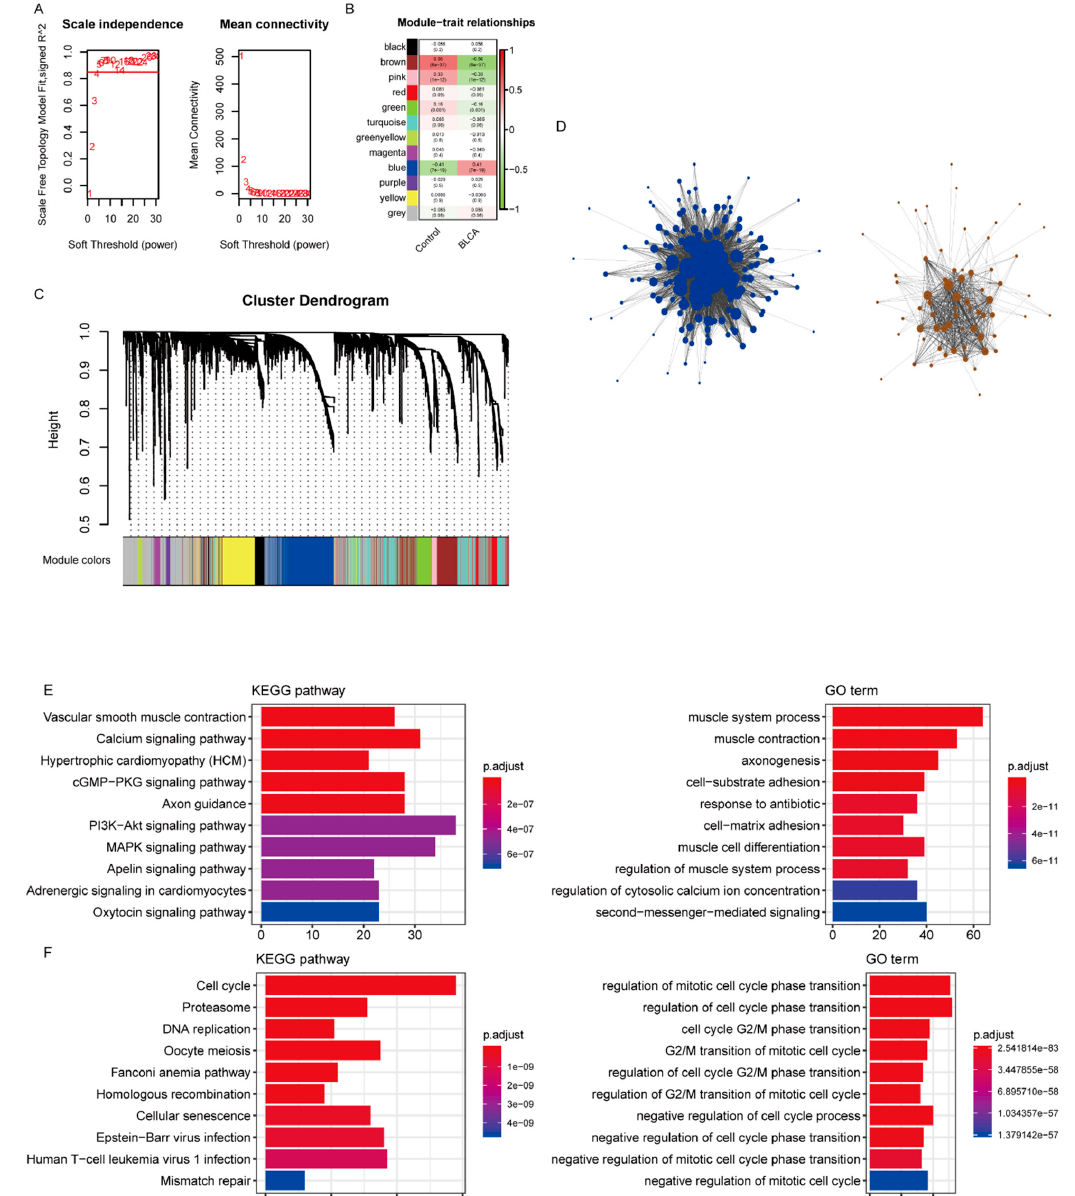
Figure 2. Identification of modules associated with bladder cancer (BC). ( A ) Analysis of the scale- free fit index and average connectivity of the 1–20 soft threshold power ( B ) In order to ensure that the network is a scale-free network, the optimal β = 5 was selected. B. Module–trait relationships. ( C ) Genes were grouped into various modules by hierarchical clustering. Each module has been color coded. ( D ) The network construction with the significantly correlated brown and blue modules. ( E , F ) The functional enrichment analysis of the genes in the brown and blue